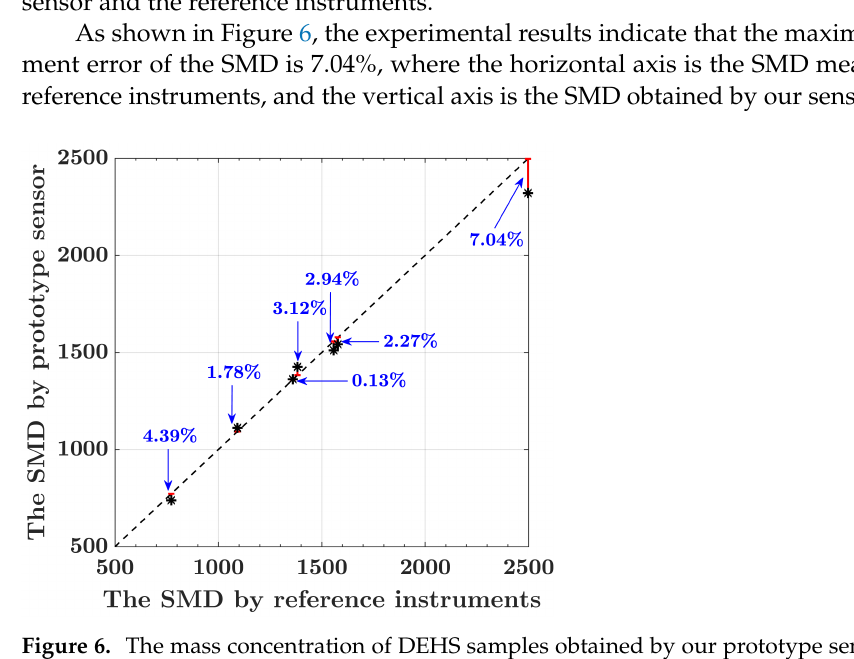
Figure 6. The mass concentration of DEHS samples obtained by our prototype sensor versus the reference instruments.